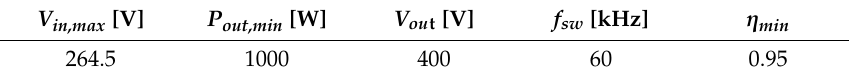
Table 1. Main inductor design constraints.